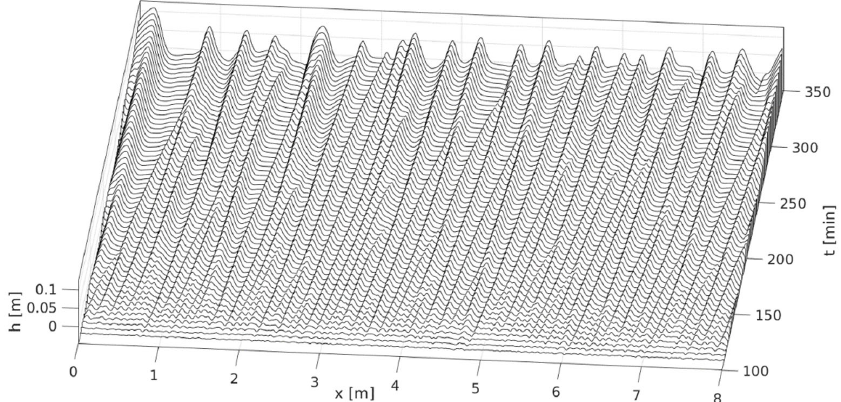
Figure 6. Bedform evolution due to the coarsening process during 250 min of numerical simulation. Smaller ripples move faster than larger ripples, resulting in collisional merging that cause average ripple size to increase with time.